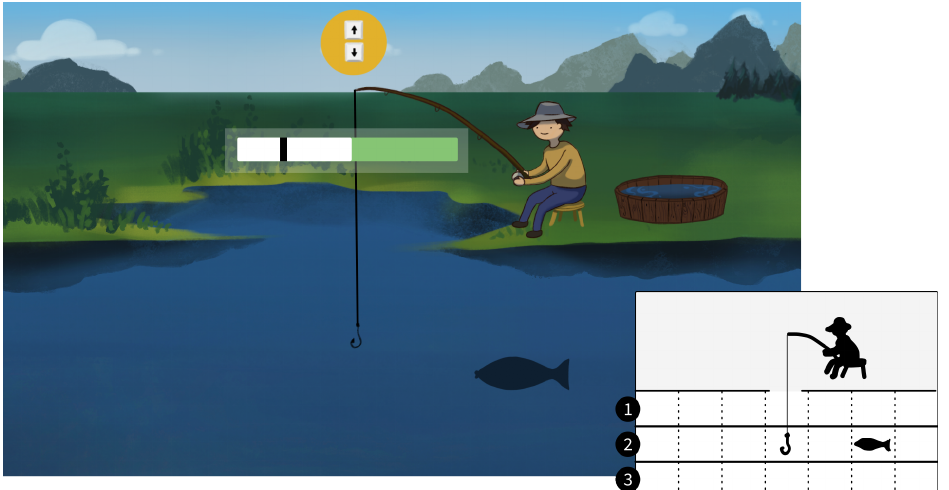
Figure 2. In the fishing game, participants control a fisherman reeling fish. Participants use arrow keys to move the hook up and down between three lanes. A fish may appear in a random lane from either left or right side and may swim into the participant’s hook. The BCI input window then begins and the participant may then perform MI when the black cursor is within the green